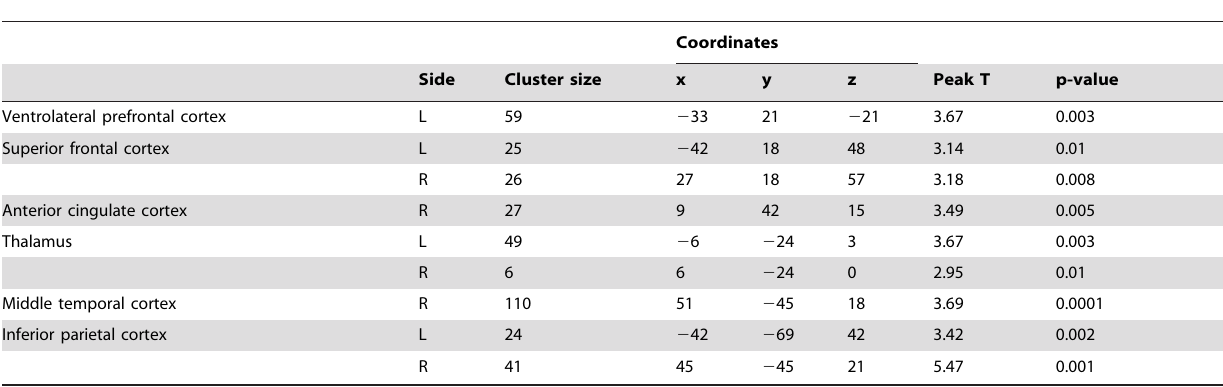
Table 3. Control . FM activation two sample t-test ( P , 0.05 small volume corrected for multiple comparison and minimum cluster size of